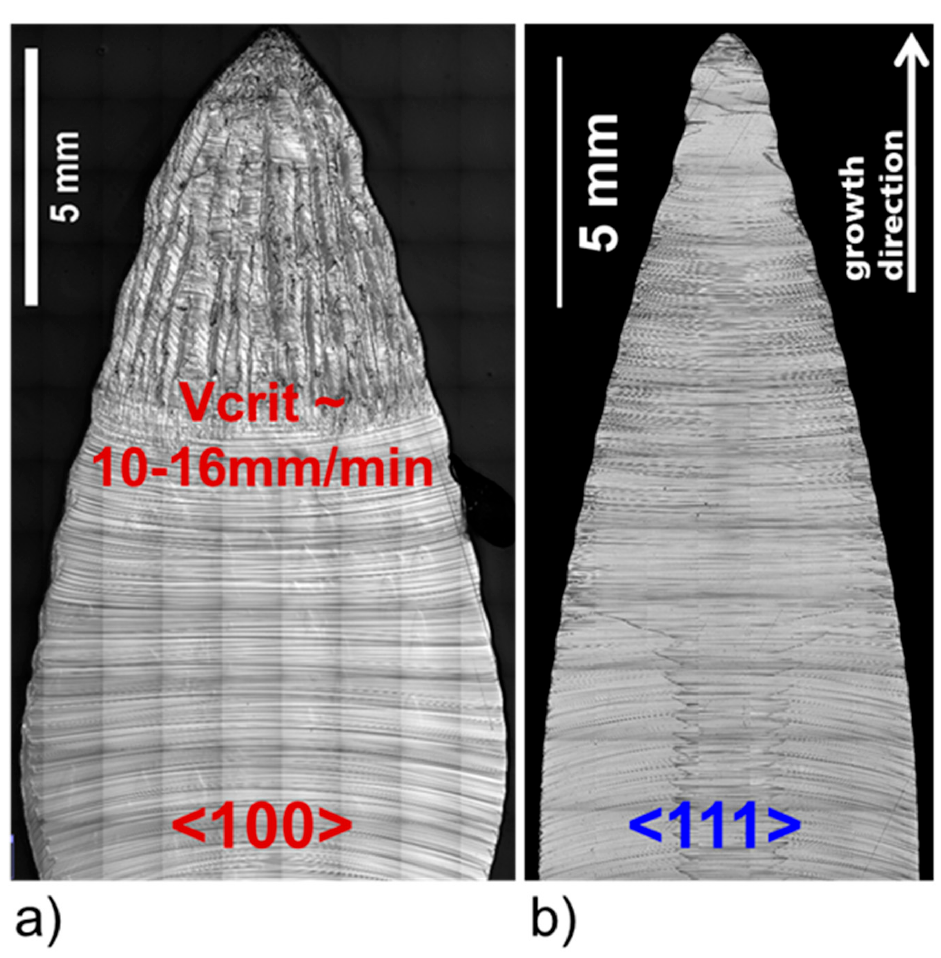
Figure 9. Microscope images of vertical cuts of two etched silicon samples to illustrate the evolution of the interface during the last portion of the crystal growth process. ( a ) <100>-oriented crystal exhibited interface instability when the growth rate exceeded 10–16 mm/min; ( b ) <111>-oriented crystal did not exhibit signs of morphological instability.